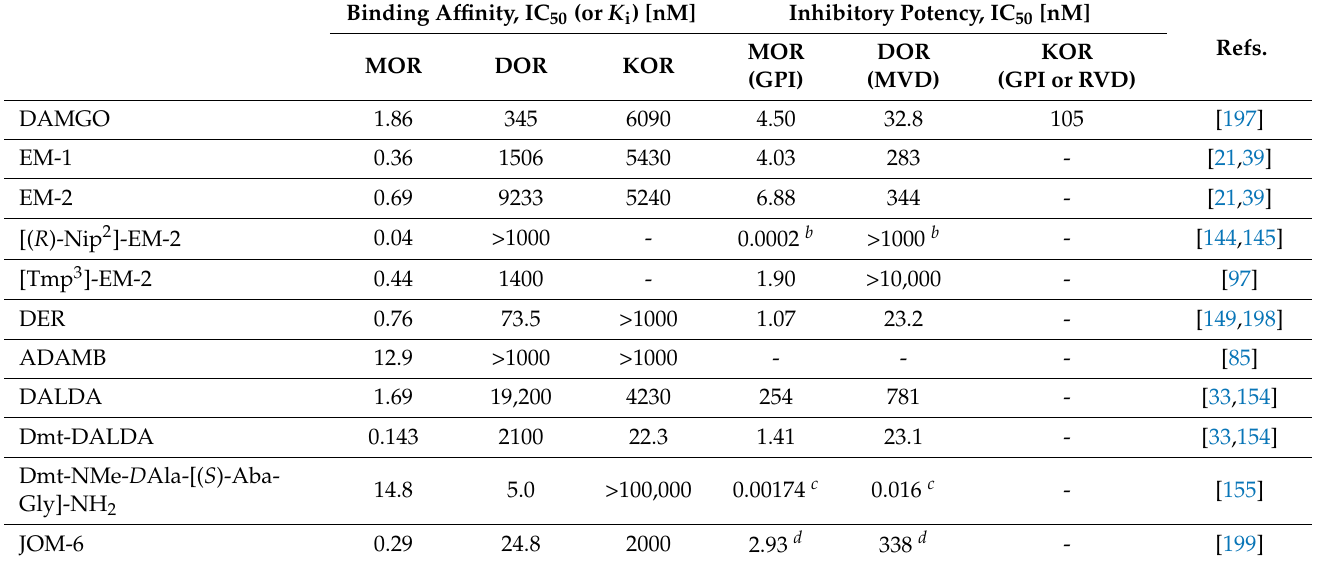
Table 2. In vitro biological activities of representative opioid peptides and peptidomimetics at MOR, DOR, and KOR a